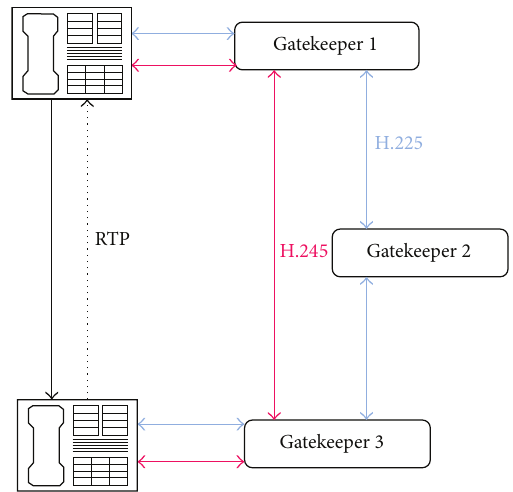
Figure 2: Diagram of a communication with 3